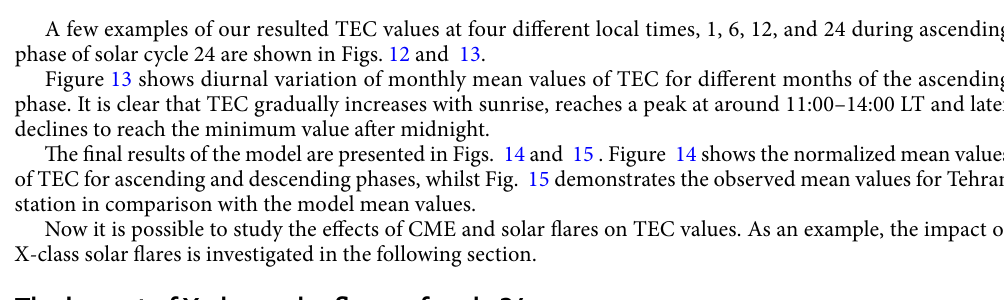
Figure 13. Seasonal variation of daily mean normalized TEC values at different months during the ascending phase of the solar cycle 24 (2009–2013). The continuous thick curve presents the resulted fourier series before using